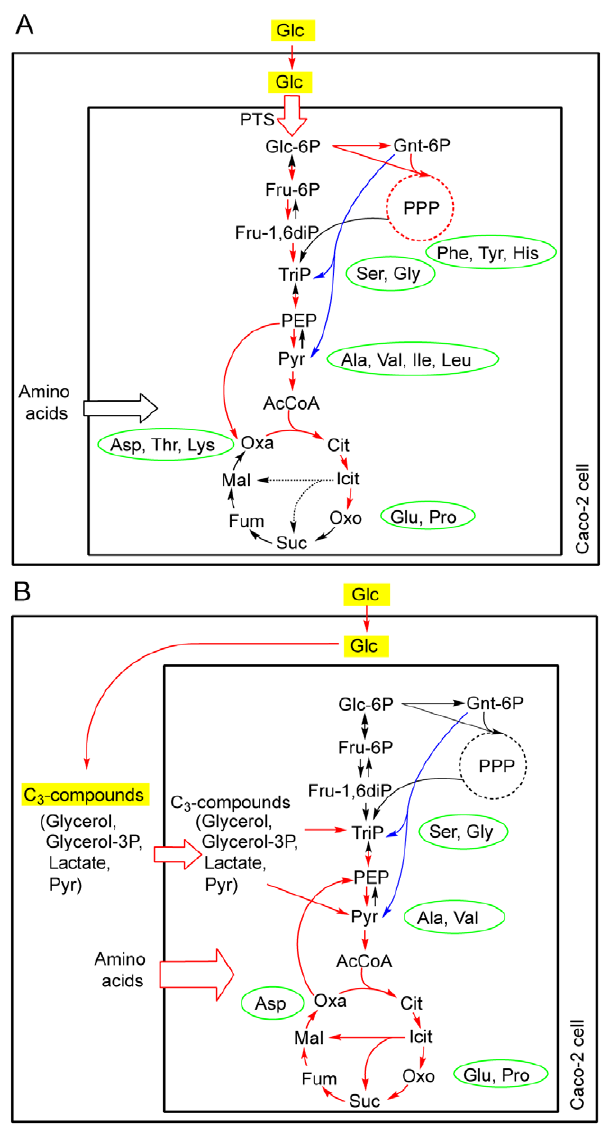
Figure 5. Proposed catabolic pathways and metabolite fluxes employed by the enterobacterial strains replicating in Caco-2 cells. Amino acids (in part) de novo synthesised by the bacteria are encircled in green. The import of 13 C-labelled amino acids from the host cell is indicated by arrows, the magnitude of which roughly reflects the relative amount of imported amino acids under the conditions (A) and (B). EIEC -1 wild-type strain and Stm follow the metabolic pathways shown in A (red arrows) which is mainly fed by glucose (indicated in yellow), while the glucose/glucose-6P uptake mutants essentially follow the metabolic pathways shown in B (red arrows) mainly fed by C 3 - substrates. EIEC -2 appears to combine the pathways of model A and B.